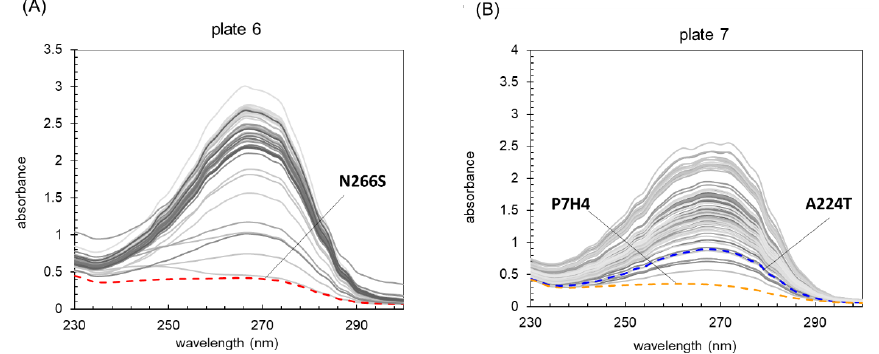
Figure 1. The UV absorbance spectrum of OxdYH3-3 mutants. OxdYH3-3 mutant clones were inoculated in 96 deep well plates, and fully-grown cells were transferred to new 96 well plates to screen OxdYH3-3 mutants that showed an improving activity to 2-furfuryl aldoxime. 10 mM furfuryl aldoxime was added in the plate, and, after a specific time, the reaction mixture was isolated and diluted. The UV absorbance between 230 and 300 nm was measured. Among 10 microplates, N266S was found in plate 6 ( A ), P7H4 and A224T were found in plate 7 ( B